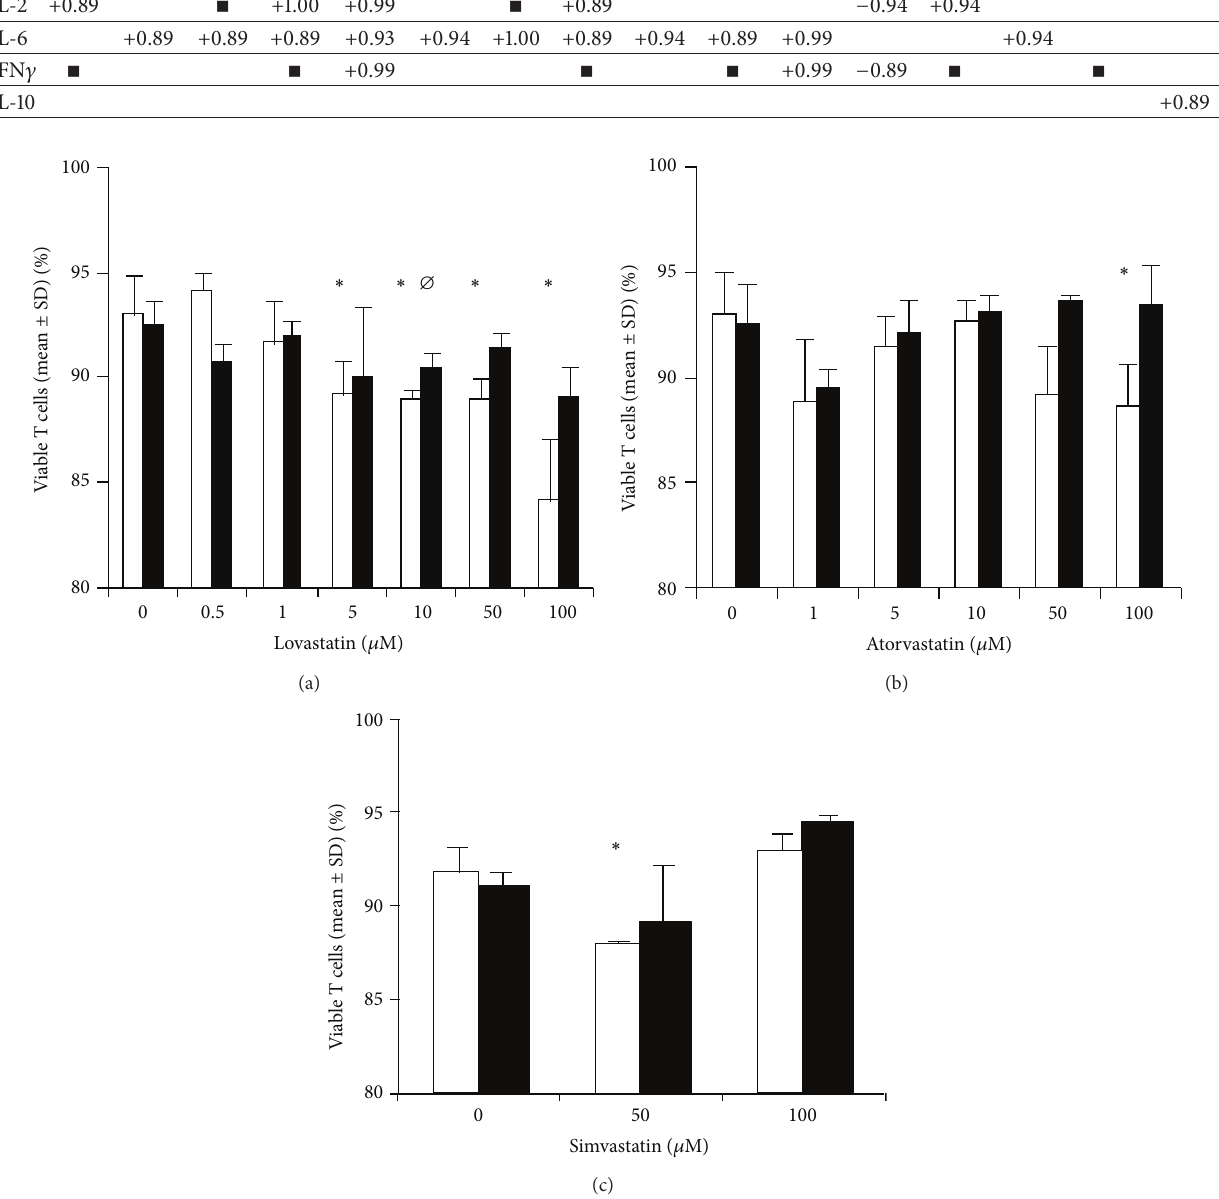
Figure 1: Cell viability was assessed at all concentrations of statins. The percentage viability is compared in the presence (filled bars) or absence of mevalonate (clear bars). ∗ denotes a statistical difference between viability of cells in different concentrations of statins ( 𝑃 < 0.05 ), and ⌀ indicates a difference in viability with and without mevalonate ( 𝑃 < 0.05